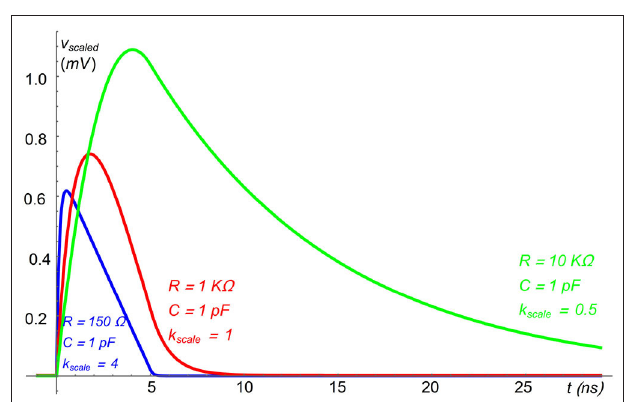
FIGURE 5 | Examples of V RC ( t ) for various values of R , computed using the toy model discussed in the text; the amplitude of the signals has been scaled k scale V RC ( t for better displaying: V scaled ( t ) =